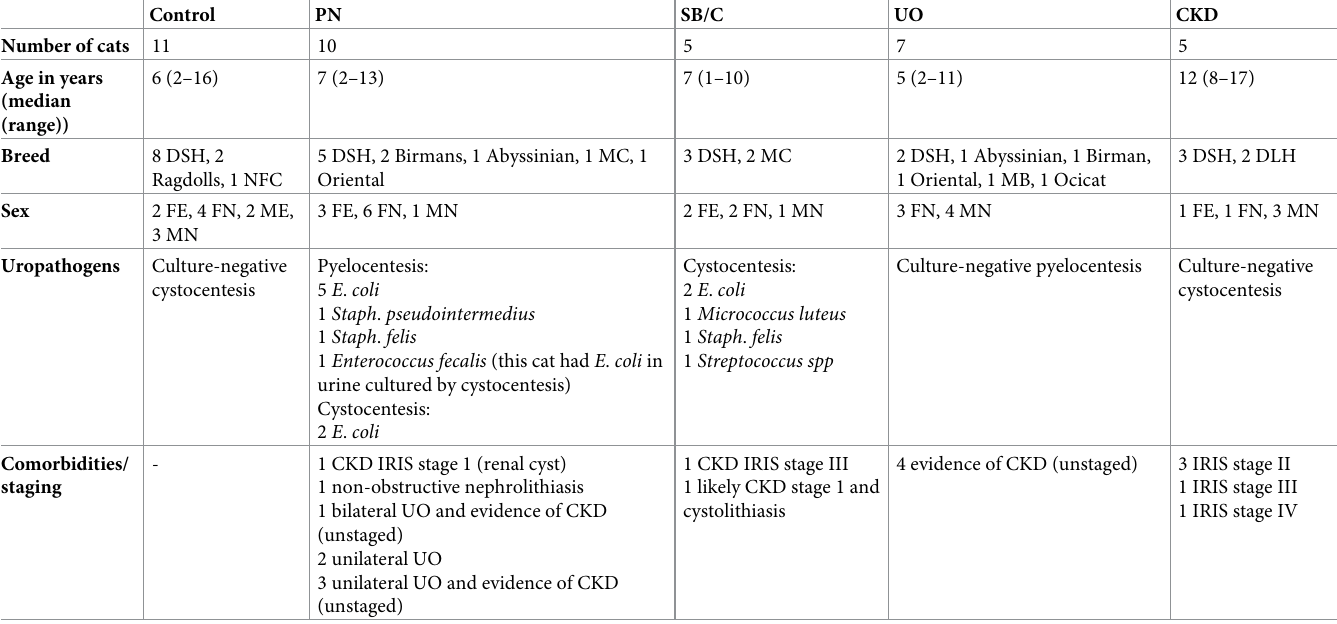
Table 1. Demographic and microbiological data of included